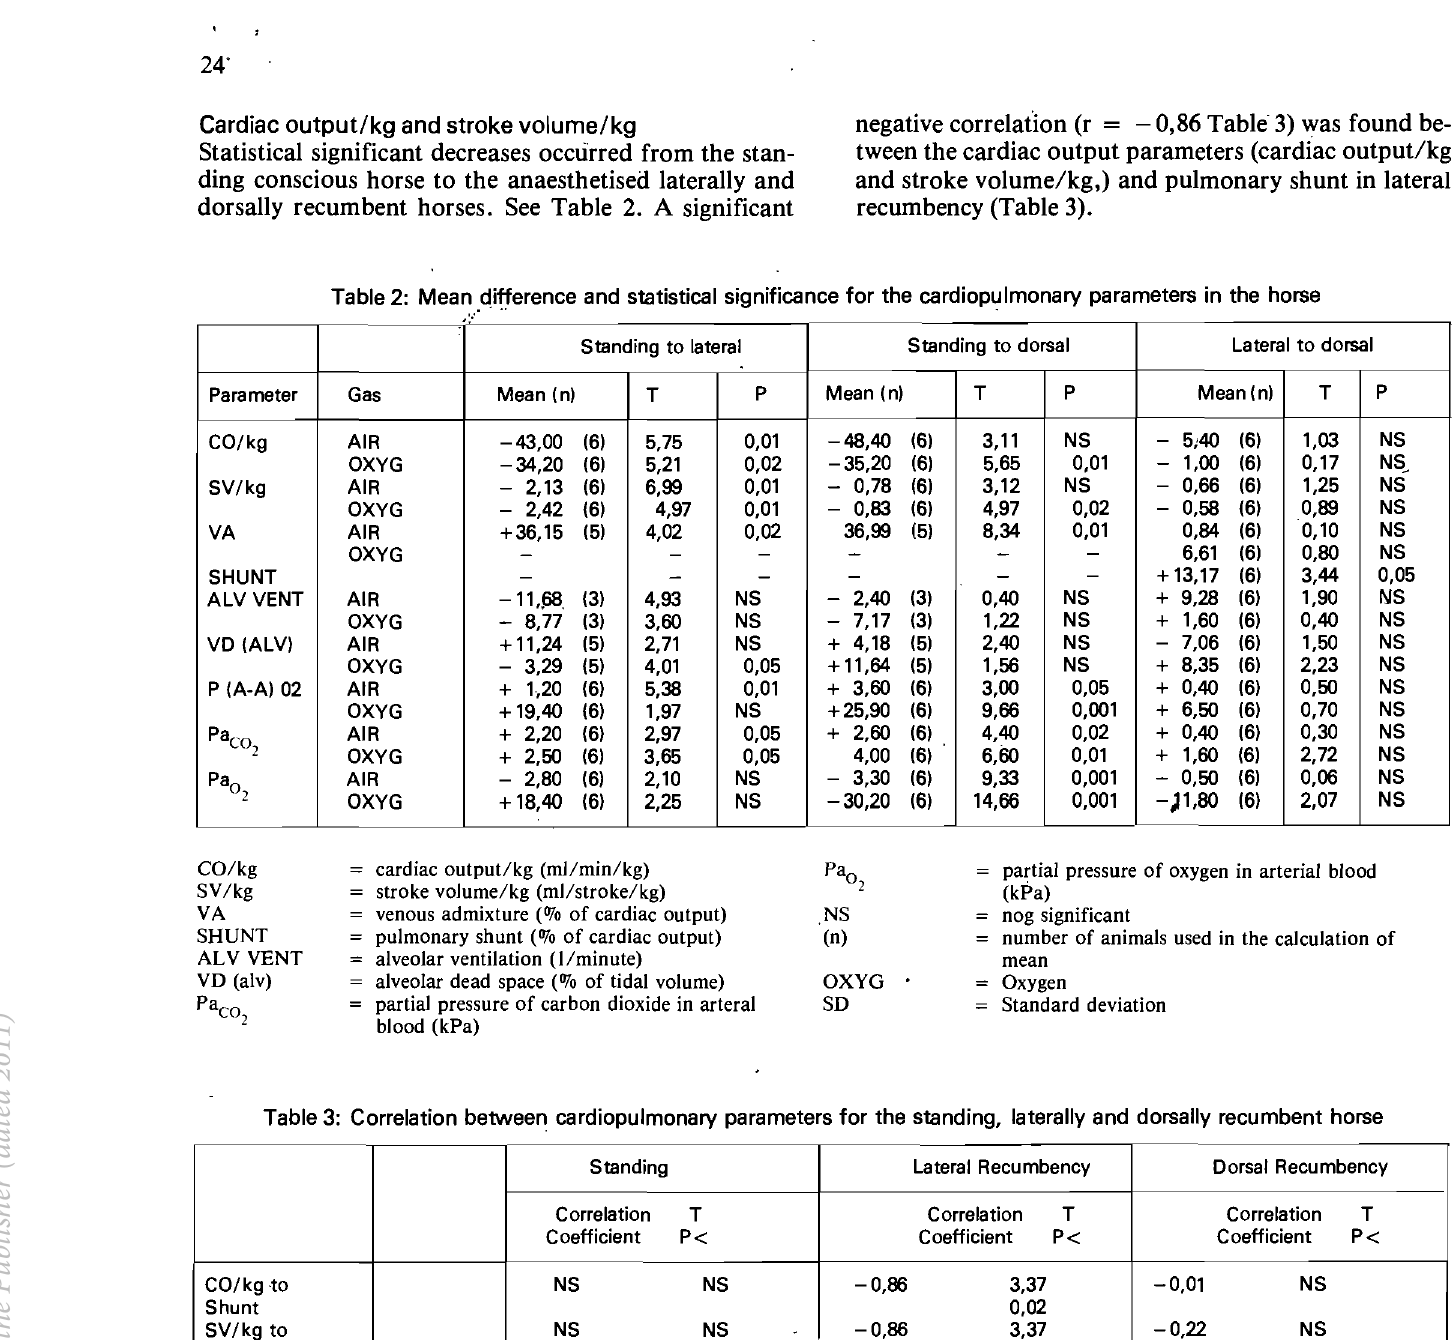
Table 2: Mean.difference and statistical significance for the cardiopulmonary parameters in the horse